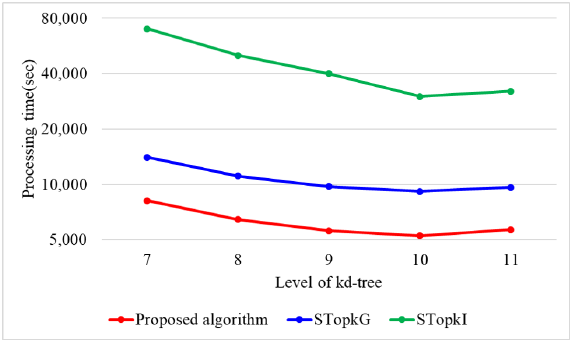
Figure 8. Processing time with varying levels of k d-tree.